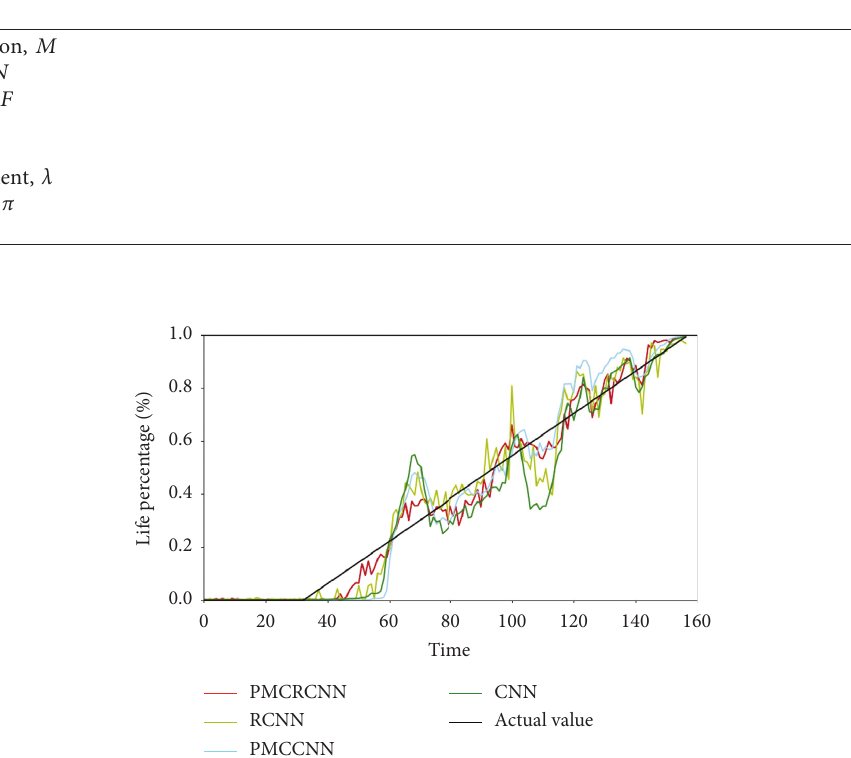
Figure 7: The prediction result of the proposed